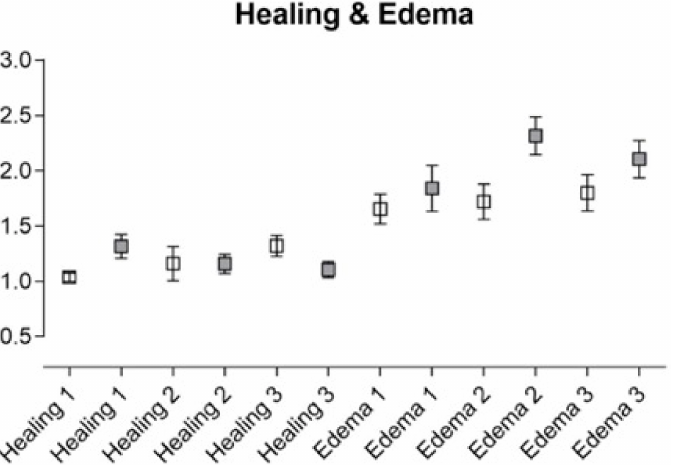
Figure 3. Edema score from wound and wound edge over the three observation points. Shown is the mean with error bars indicating 95% confidence